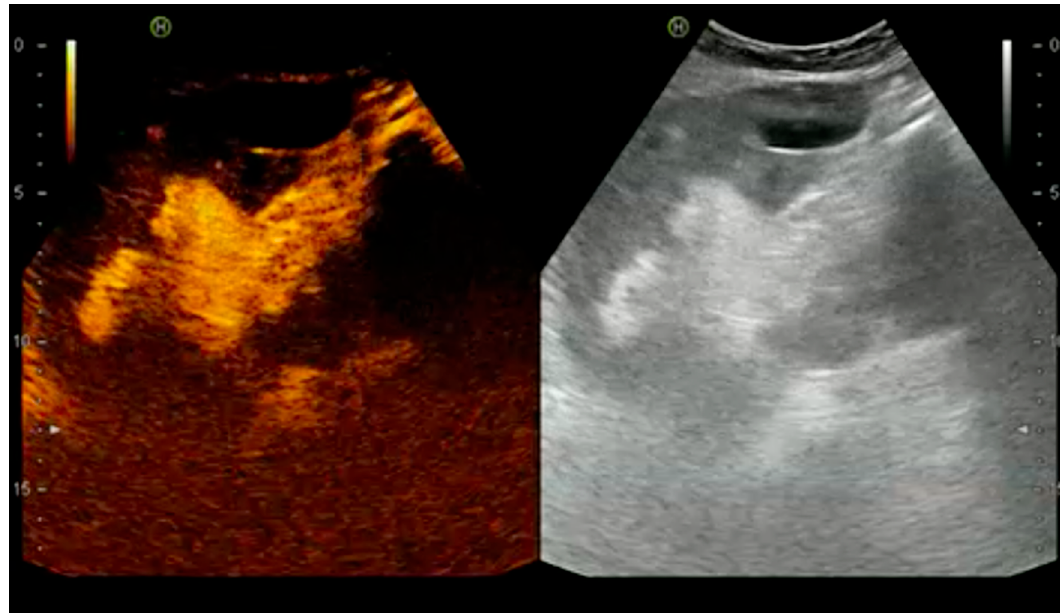
Figure 6. Renal abscess at the lower pole, seen as anechoic areas without contrast-enhancement.